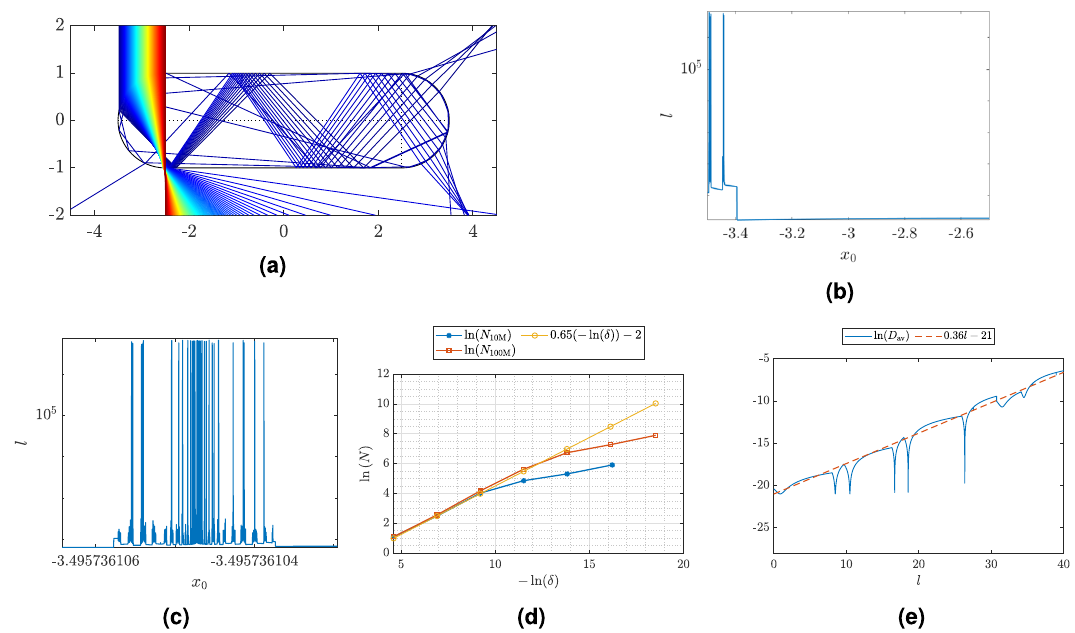
Figure 4. Frame ( a ) shows how rays sent straight downwards toward the left end cap refract when hitting the scatterer. Frame ( b ) indicates the length of the each ray, l , inside the scatterer as a function of start position x 0 with a logarithmic y -axis. Frame ( c ) also indicates the length of each ray as a function of start position. A selected interval within the x 0 -interval in frame ( b ) has been magnified, a new x 0 -interval is selected and magnified and so on. In frame ( c ), the x 0 -interval has been magnified 7 times. The fractal structure is preserved. (See Supplementary Materials Sec. E for further magnifications revealing the fractal structure.) Frame ( d ) shows the determination of the fractal dimension of the set of long-lived rays based on the box-counting method. The blue and red lines show ln ( N ) as a function of − ln (δ) where N is the number of intervals that contain at least one long-lived trajectory and δ is the width of the interval. The slope of the blue and red lines are indicating the fractal dimension. The yellow line indicates that the slope is 0.65. N 10M , the blue line, indicates N for the case where 10 million rays were started in the interval and N 100M , the red line, where 100 million rays were started in the same interval. Frame ( e ) shows the average of ln ( D ) , where D is the distance between the two rays, as a function of path length, l , for 10 pairs of rays. The red, dashed line indicates the slope, i.e. the Lyapunov exponent, which in this case is 0.36. For all the frames, the refractive index of the scatterer is 1.8. Classical ray tracing investigations are wavelength independent and the length of the straight part of the stadium is 5 times the radius of the end caps. This corresponds to a system where d = 50 µ m and r = 10 µ m